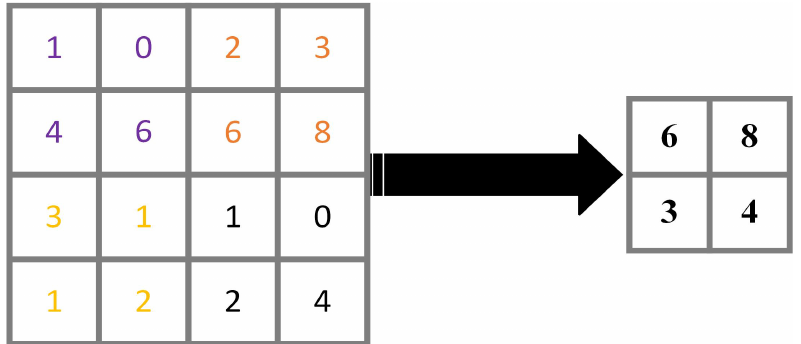
Figure 3. Schematic diagram of maximum